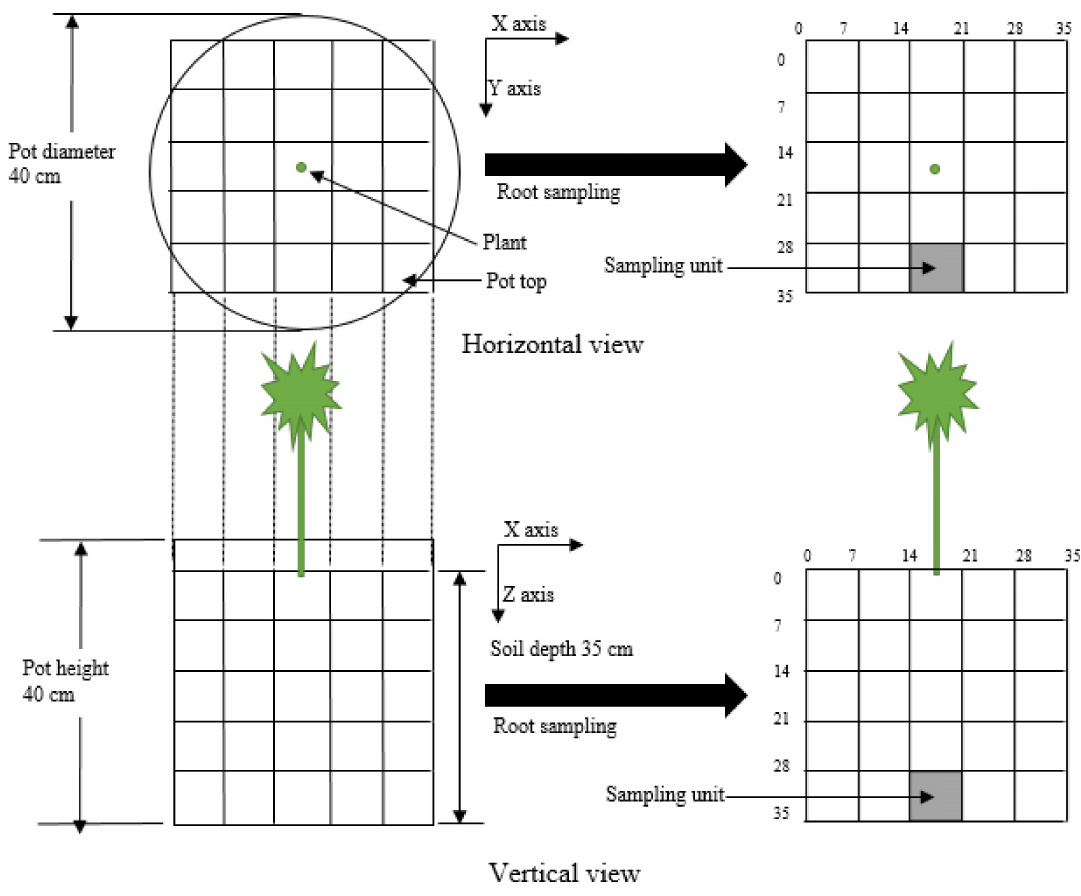
Figure 1. Diagram of a soil pot and root sampling method.